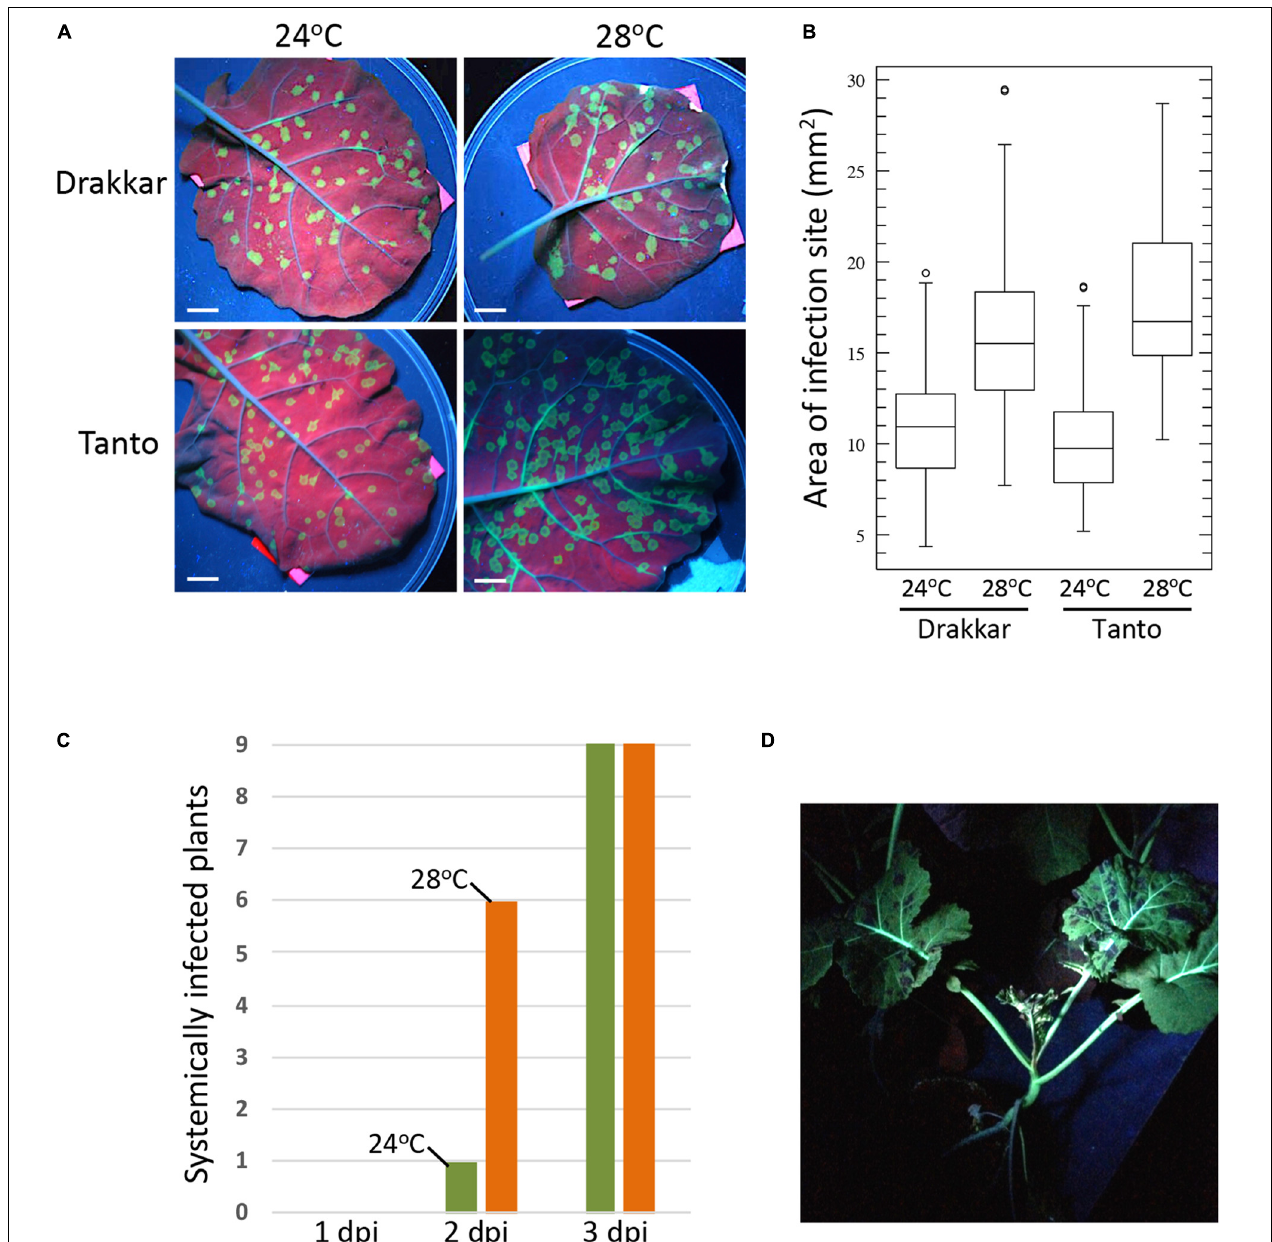
FIGURE 2 | Temperature effect on TuMV-GFP infection in B. napus cultivars Drakkar and Tanto. Plants were incubated at 20 ◦ C for 8 h (night) and 24 ◦ C for 16 h (day) until two leaf stage. Half of the plants were then transferred to 20 ◦ C for 8 h (night) and 28 ◦ C for 16 h (day). Plants were allowed to adjust for 2 days before inoculation. (A) Effect of temperature on viral cell-to-cell spread in inoculated leaves. Pictures were taken at 6 days post inoculation (6 dpi) under UV light. Scale bar, 1 cm. (B) Sizes of individual local infection sites at 6 dpi. Infection foci in leaves of five plants per condition were measured (Drakkar 24 ◦ C, N = 117; Drakkar 28 ◦ C, N = 111; Tanto 24 ◦ C, N = 112; Tanto 28 ◦ C, N = 102. The higher temperature causes a significant increase in the local cell-to-cell spread of infection in both Drakkar (ANOVA, p = 4,3 − 21 ) and Tanto (ANOVA, p = 2,5 − 37 ). (C) Systemic spread of TuMV-GFP in Drakkar is more efficient at 28 ◦ C (orange) than at 24 ◦ C (green). Inoculated leaves of nine plants at 24 ◦ C and of nine plants at 28 ◦ C were removed after 1, 2, or 3 dpi, followed by scoring the systemic leaves for GFP fluorescence (systemic infection) at 16 dpi. A control plant from which the inoculated leaf was not removed is shown in panel (D) . (D) TuMV-GFP-infected Drakkar plant showing systemic infection at 21 dpi. The picture was taken under UV